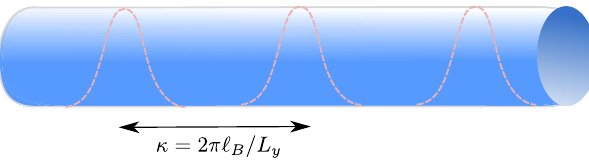
FIG. 11. In the limit of a thin cylinder ( κ → ∞ ), the single- particle orbitals become well separated from one another. As a consequence, the dominant configurations ( “ root patterns ” ) in the expansion of a many-body state Ψ are those Fock states where particles minimize their classical electrostatic